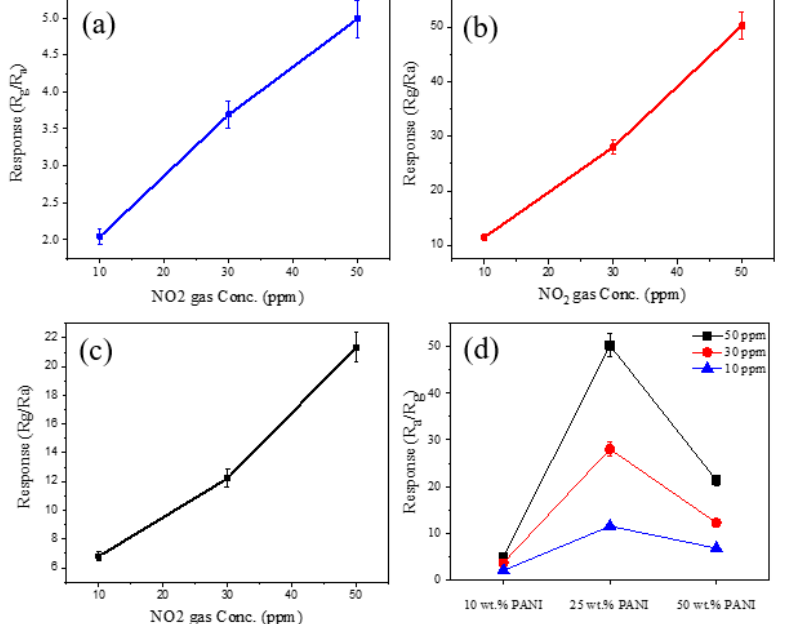
Figure 8. Calibration curves of ( a ) Au ‐ decorated ZnO ‐ PANI (10 wt.%); ( b ) Au ‐ decorated ZnO ‐ PANI (25 wt.%); ( c ) Au ‐ decorated ZnO ‐ PANI (50 wt.%) composite nanofiber gas sensors to NO 2 gas at 300 °C; ( d ) Response of composite nanofiber gas sensors to 10, 30, and 50 ppm NO 2 gas. Next, we exposed the optimized gas sensor to various amounts of NO 2 gas at various temperatures (Figure 9a). We first tested higher concentrations, and then they gradually decreased. It should be noted that when the sensing temperature is increased, the base resistance is decreased, as shown in Figure 9b. This shows the semiconducting behavior of the gas sensor [65] and is due to the jumping of electrons from the valence band of ZnO to the conduction band, increasing the conductivity. Moreover, possible structural changes of the composite at high temperatures may contribute to the increase in conduc ‐ tivity.